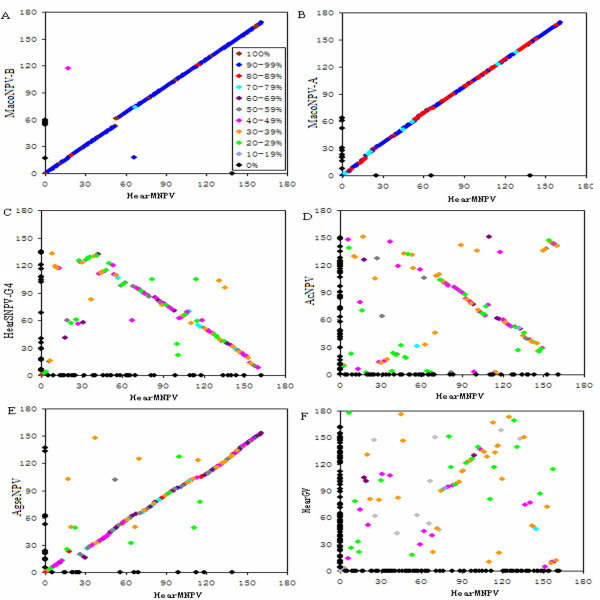
Identity-Gene Parity Plots of HearMNPV with MacoNPV-B (A), MacoNPV-A (B), HearSNPV-G4 (C), AcMNPV (D), AgseNPV (E), and HearGV (F). Amino acid identity (%) of individual homologous ORFs of HearMNPV compared to other baculoviruses are shown in various colors. ORFs unique to each virus are placed on the x-axis and y-axis, respectively (black diamonds).